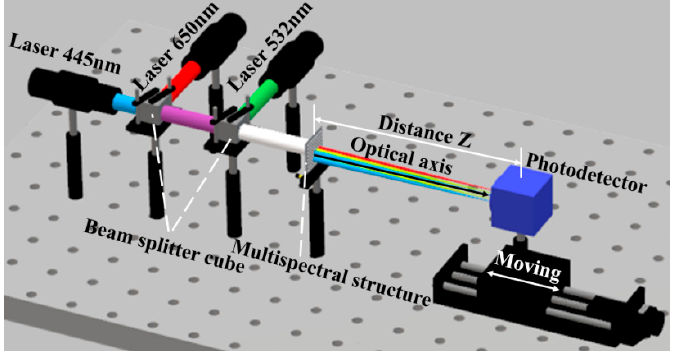
Figure 5. The light path diagram of red, green and blue laser beam combined coaxially illuminate the multi-spectral compound eye structure.